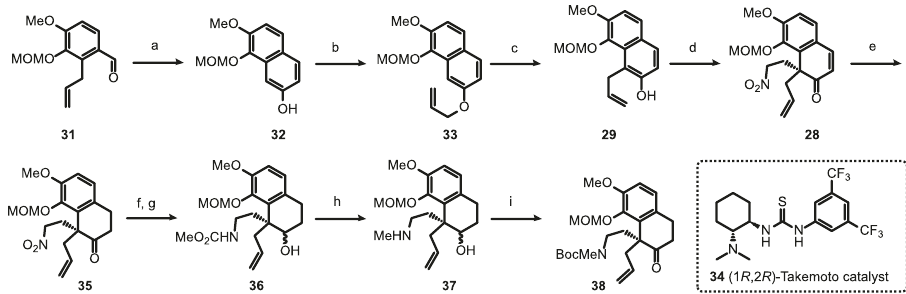
Fig. 3 Catalytic enantioselective synthesis of 1,1-disubstituted dihydronaphthalen-2-one (38). Reagents and conditions: (a) PdCl 2 (0.05 equiv), CuCl 2 (1.5 equiv), O 2 , DMF/H 2 O = 7/1, rt, then NaOH (4.0 equiv), MeOH, 73%; (b) Allyl bromide (1.5 equiv), K 2 CO 3 (1.5 equiv), acetone, re fl ux,